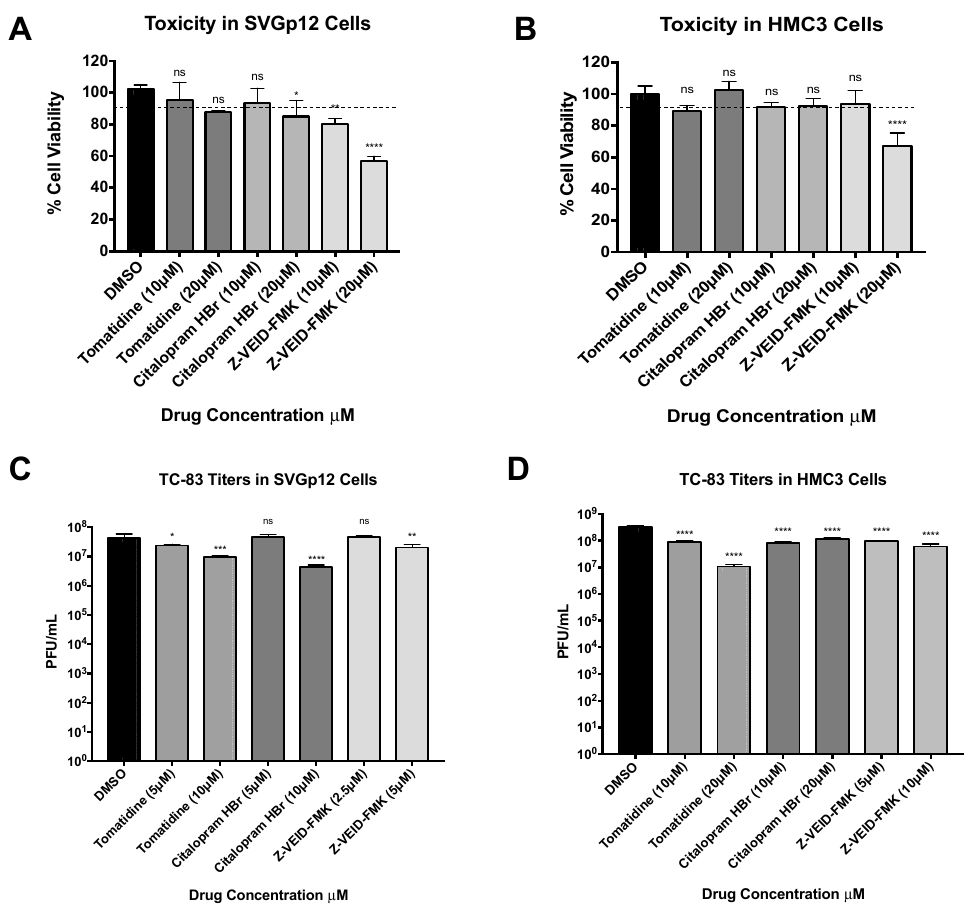
Figure 3. Tomatidine, citalopram HBr, and Z-VEID-FMK can inhibit TC-83 replication in multiple cell types. SVGp12 and HMC3 cells were treated with two concentrations of tomatidine, citalopram HBr, and Z-VEID-FMK. ( A , B ) Cell viability was measured at 24 hpt and calculated versus the DMSO vehicle control, as described in Materials and Methods. The dotted line represents the 90% cut-off point. ( C , D ) Cells were treated and infected in triplicate, as previously described (MOI 0.1), and viral supernatants were collected and evaluated by plaque assay, as described in Materials and Methods. Graph represents data from two independent experiments performed in triplicate ( n = 6). * p < 0.0332, ** p < 0.0021, *** p < 0.0002, **** p < 0.0001, ns, not